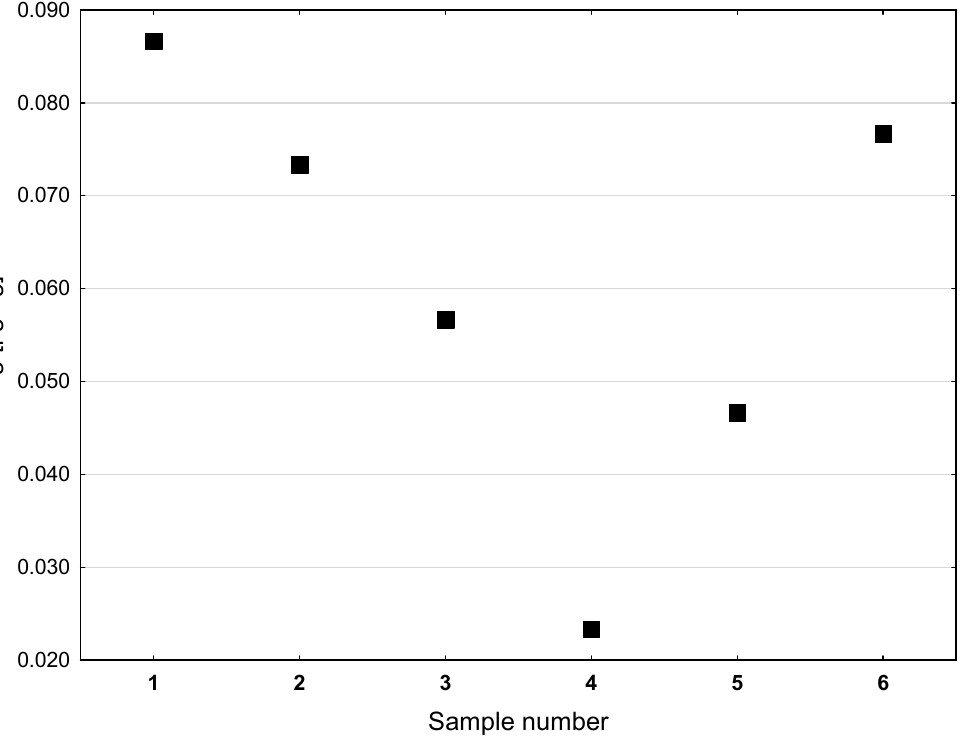
Figure 3. Hg concentrations in dietary supplements made with shark liver oil (µg/kg).